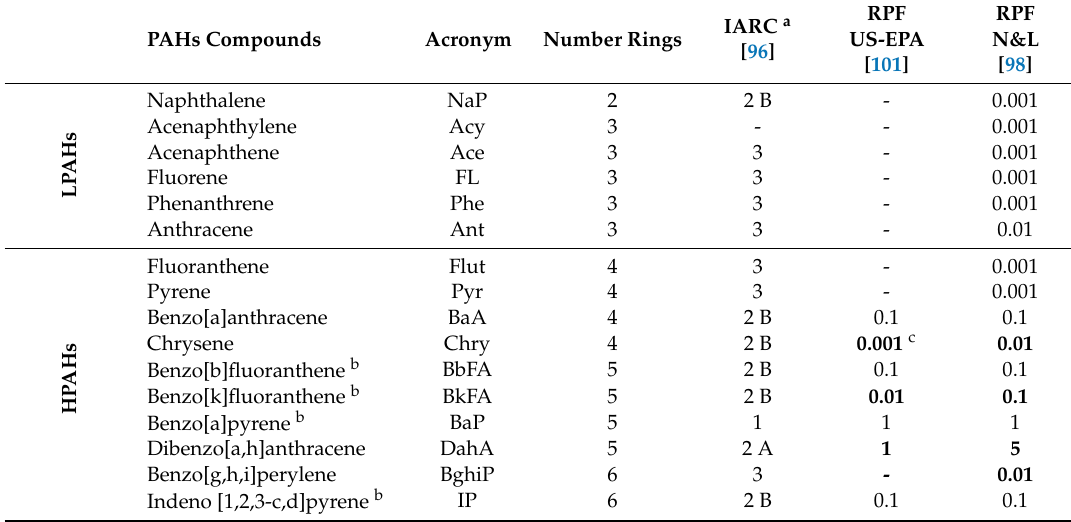
Table 2. List of Polycyclic Aromatic Hydrocarbons (PAHs), Carcinogenicity Classification and Toxicity Factors for BaP-EQ calculations.